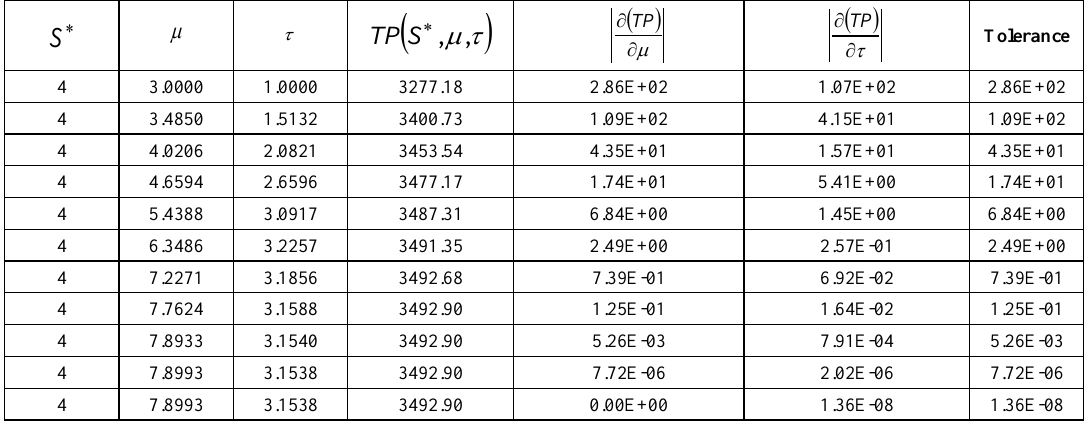
Table 8. An illustrative example of the Newton-quasi method.